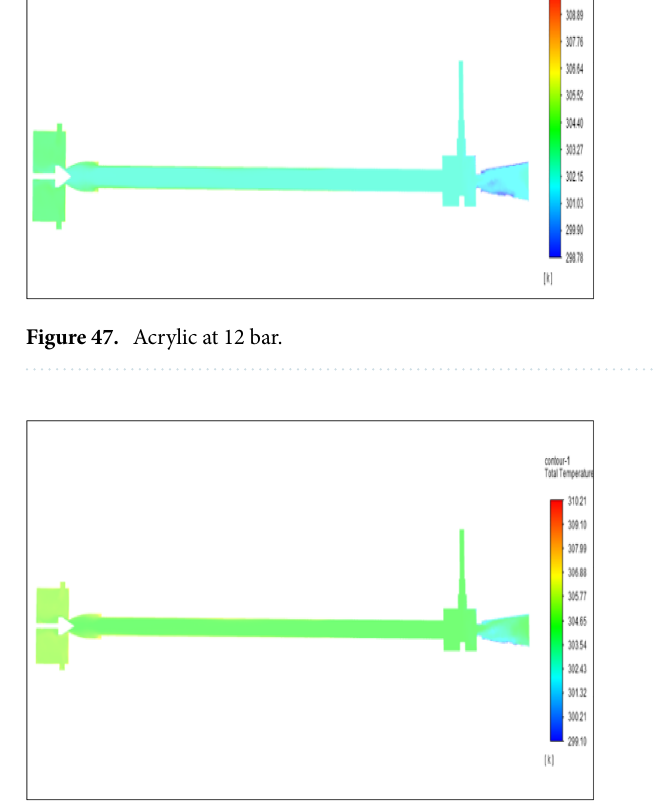
Figure 48. Nylon at 12